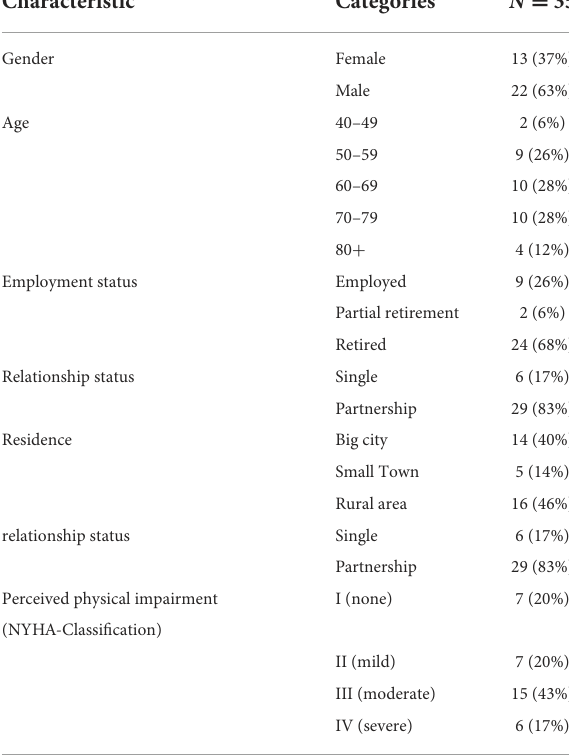
TABLE 2 Participant characteristics. TABLE 3 Main codes, sub-codes, and frequency of physical activity